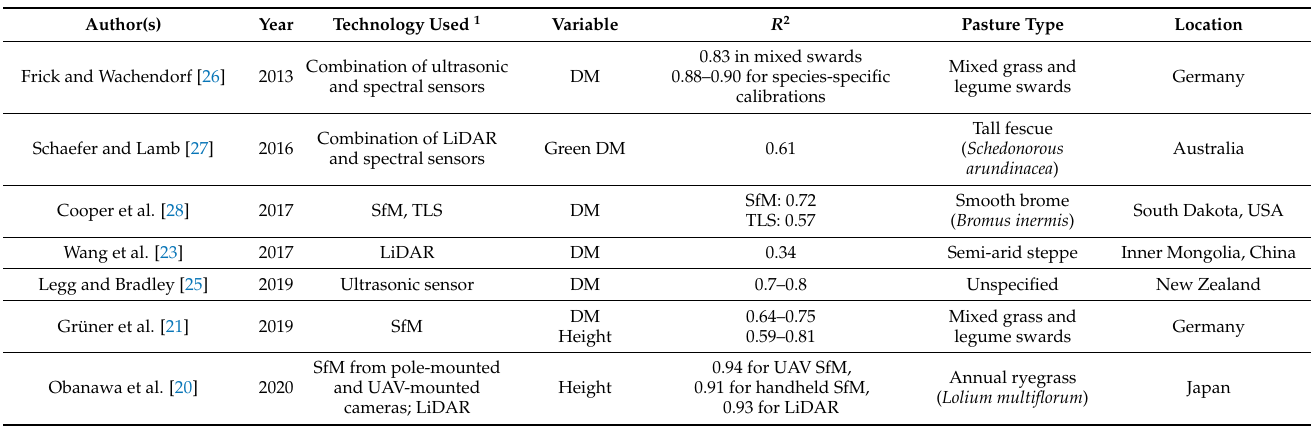
Table 1. Studies using proximal sensing technologies to estimate pasture height or dry matter (DM)